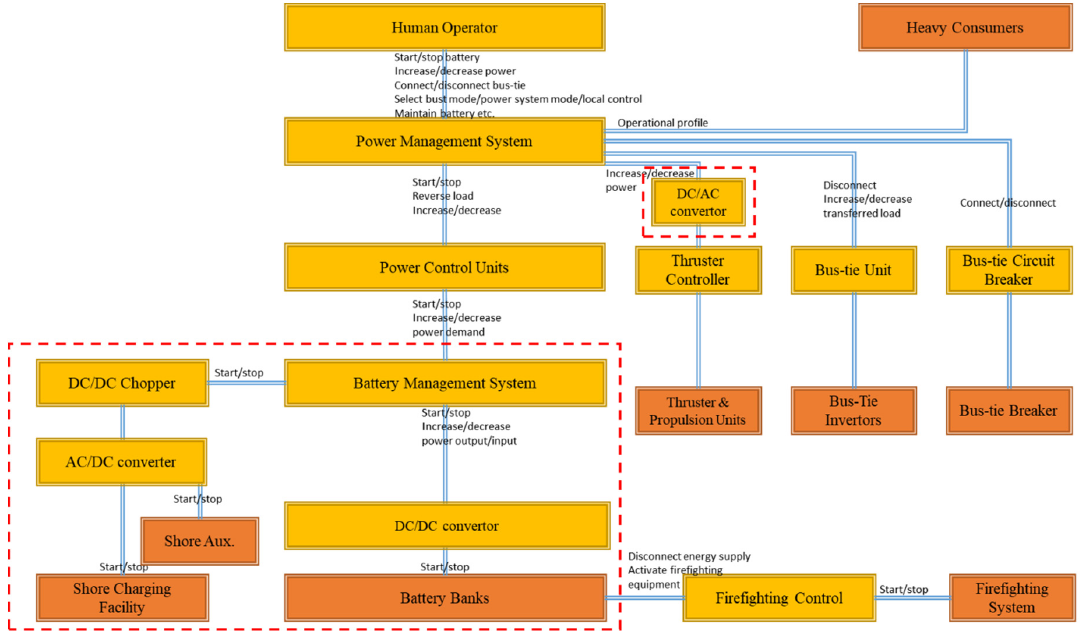
Figure 4. System diagram of battery power plant.